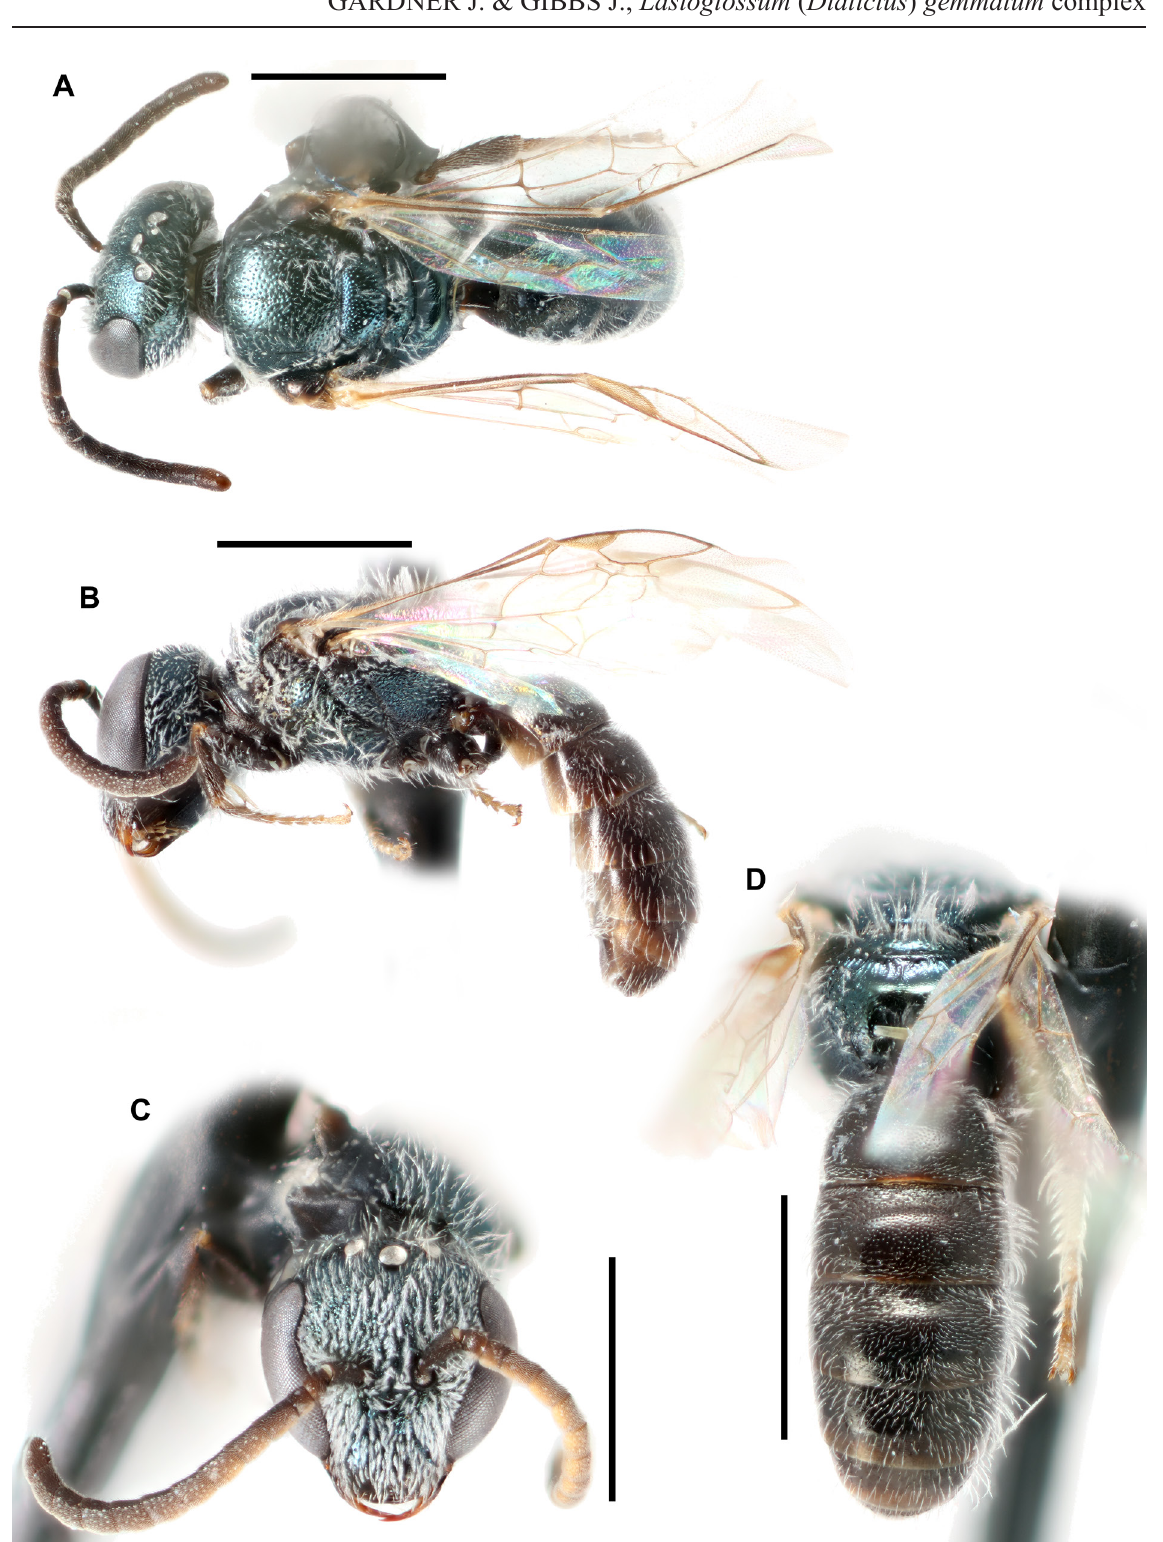
Fig. 34. Lasioglossum ( D .) holzenthali sp. nov., ♂ (CAVE40602). A . Dorsal habitus. B . Lateral habitus. C . Face. D . Metasoma and propodeum. Scale bars = 1